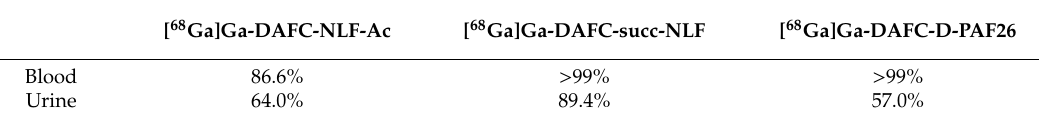
Table 4. In vivo stability of di ff erent antifungal conjugates radiolabelled with gallium-68. Samples from BALB / c mice 10 min after injection into the tail vein. Values reflect intact conjugate measured by radio-HPLC analysis (expressed as % radioactivity of intact conjugate in relation to